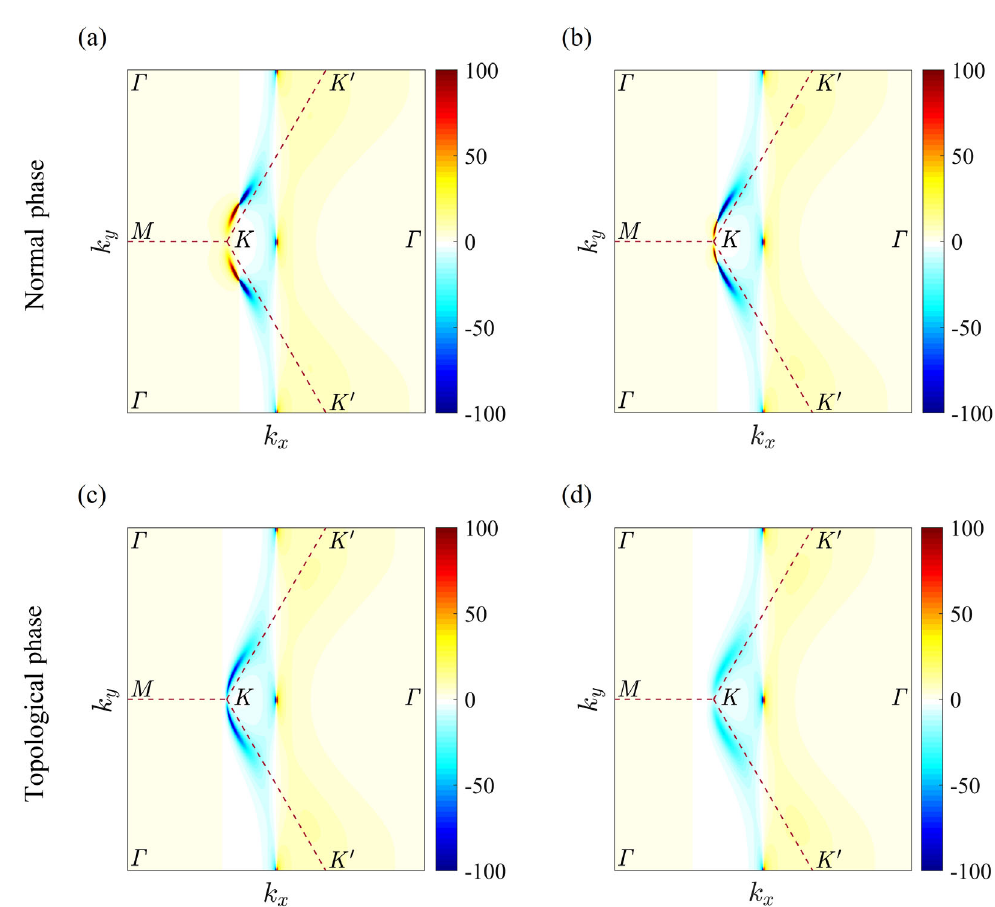
FIG. 3. Shift vectors along the k in Fig. 2(b)] of the KM model with (a) λ ν = ð 3 ffiffiffi p 3 λ Þ ¼ 0 . 8 . In the vicinity of the K point, the shift-vector peak is positive in the normal phase [(a,b)] and negative (d) λ ν = ð 3 SO